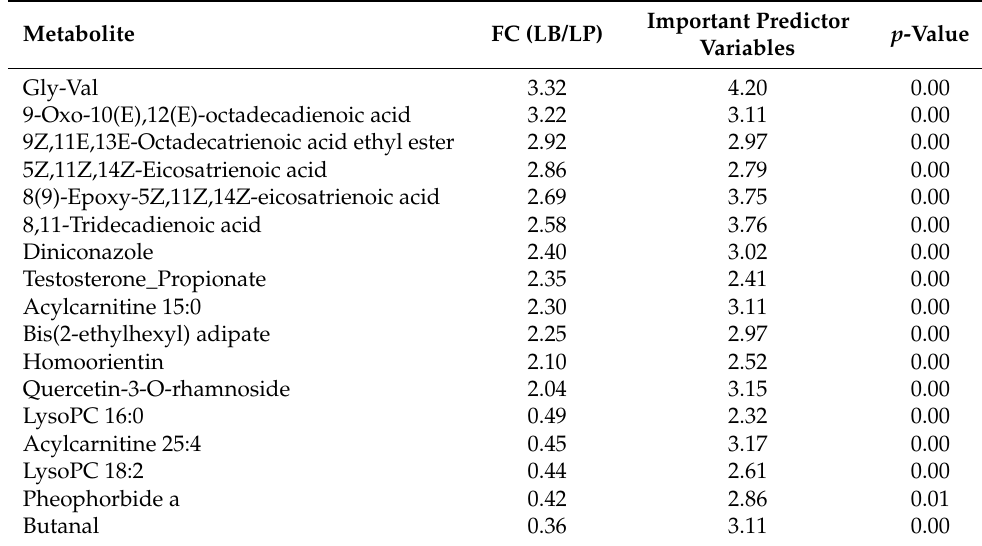
Table 5. Metabolite differences of whole crop corn silage between LB and LP groups.